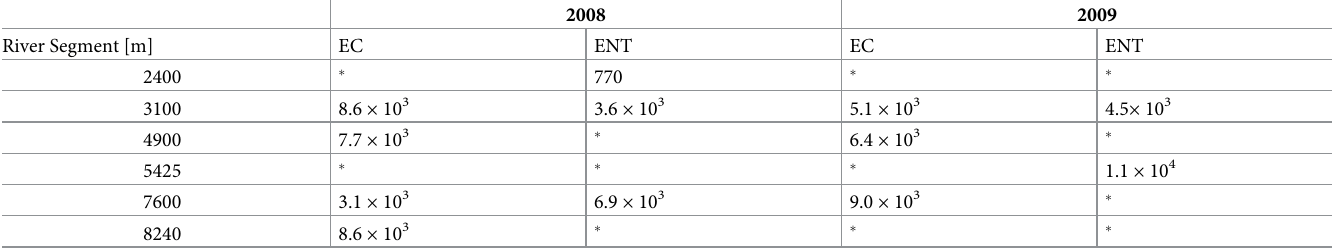
Table 7. Required groundwater fluxes of FIB to achieve river loadings of FIB observed in the field. Units of the reported values are MPN/s/m.